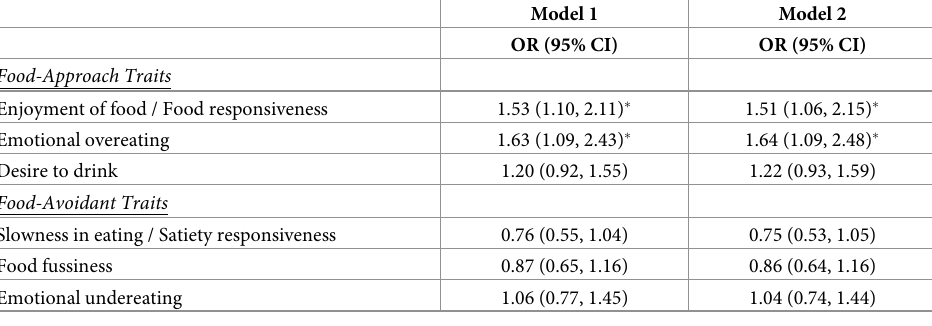
Table 2. Associations between child appetitive traits at 5 years old and food reward at 6 years old (n = 326).